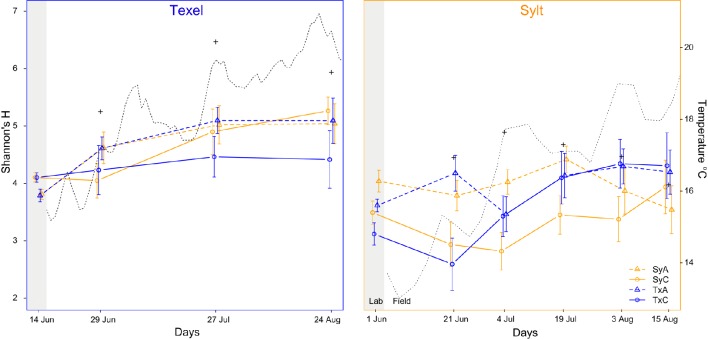
α-diversity of hemolymph and seawater (+) microbiota on Texel (left, blue frame), and Sylt (right, orange frame) throughout the sampling period. The dotted line represents mean daily temperature at the sites. Legend explanation: Sy and Tx refer to the oyster origin, A and C to antibiotic treatment and control, respectively.